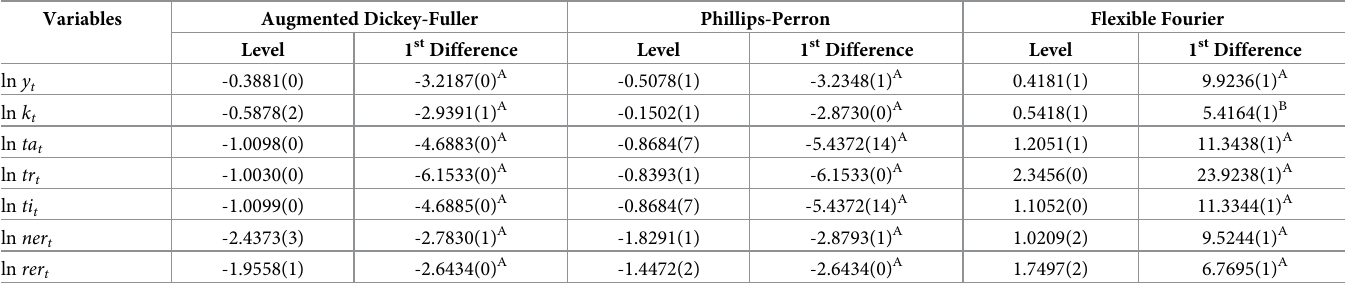
Table 4. Unit root tests.